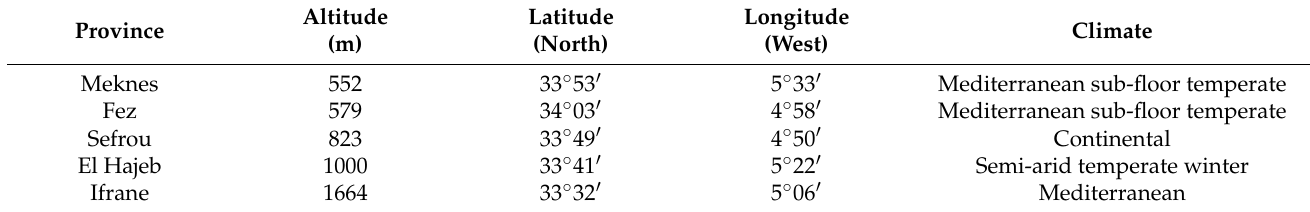
Table 1. Characteristics of the studied